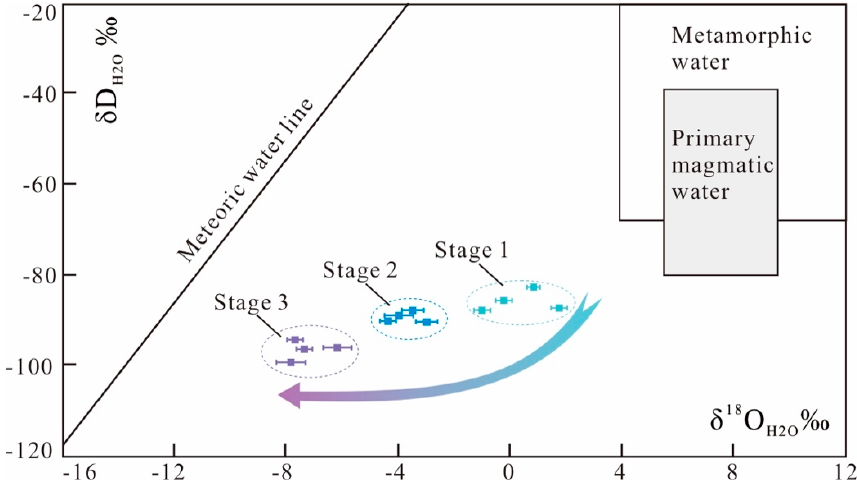
Figure 8. Diagram showing δ D H2O vs. δ 18 O H2O , representing different stages of mineralization in the Kuergasheng Pb–Zn deposit. Fields showing primary magmatic, metamorphic, and meteoric waters are from Taylor [35].